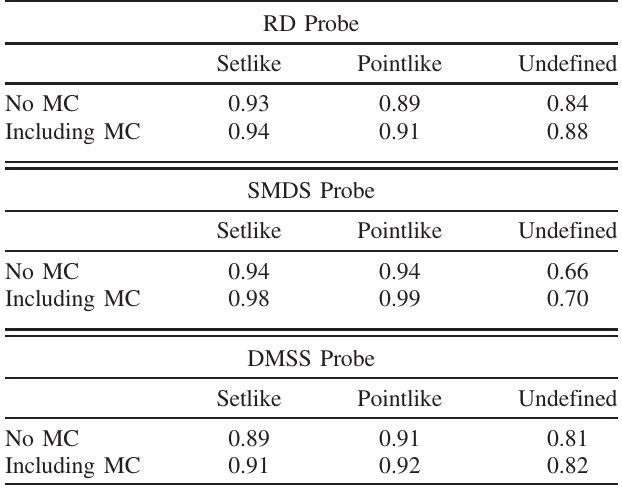
features including a one-hot encoding of multiple choice (MC) and excluding a multiple-choice